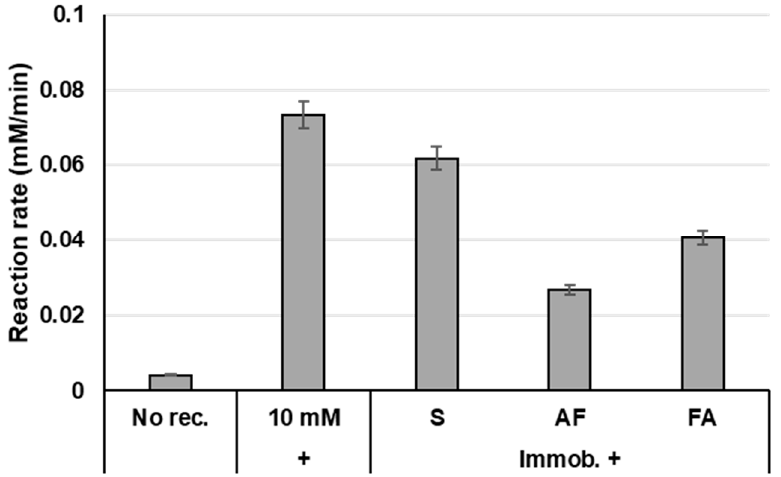
Figure 3. Reaction rate for the amination of vanillin. In all cases, the reaction consisted of 10 mM vanillin, 1 eq. of alanine, 250 mM ammonium formate, 1 mM NAD+, 0.1 mM PLP with 2 mg/mL of CvTA and 20 mg of the immobilised biocatalyst (S: simultaneous immobilisation; AF: HeAlaDH followed by CbFDH and FA: CbFDH followed by HeAlaDH).